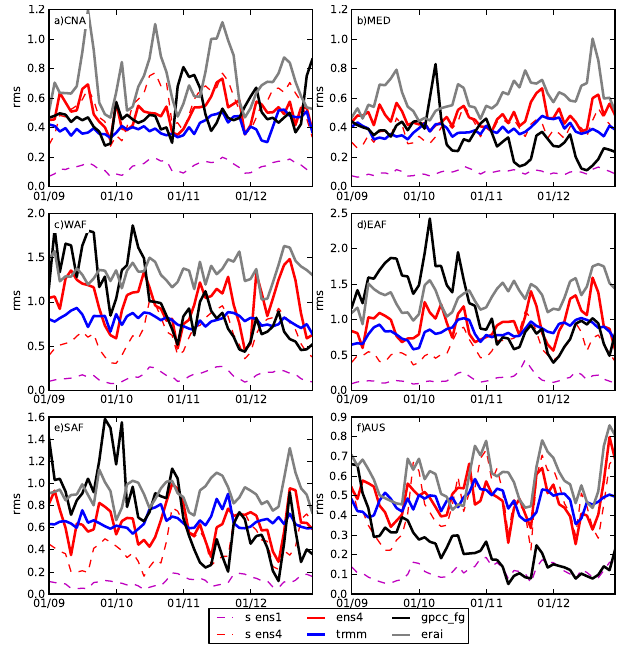
Figure 4. SPI-3 time series of the spread around the ensemble mean in ENS1 (dashed magenta) and ENS4 (dashed red), and root mean square (RMS) error of ENS4 ensemble mean (red); TRMM (blue), GPCC_FG (black) and ERAI (grey) for six different regions. The RMS errors are calculated in respect to